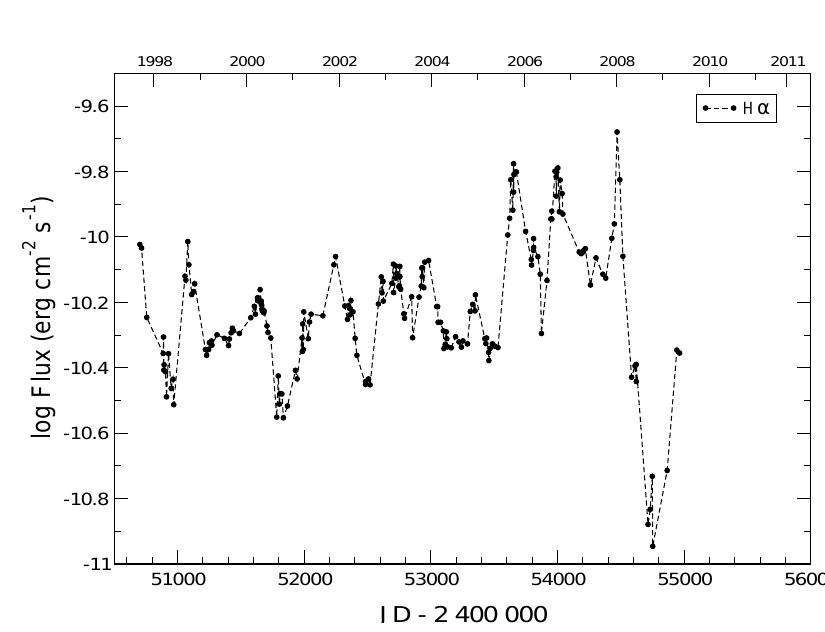
Fig. 6. Absolute (cid:13)uxes emitted in the H (cid:11) line in 1997{2009.